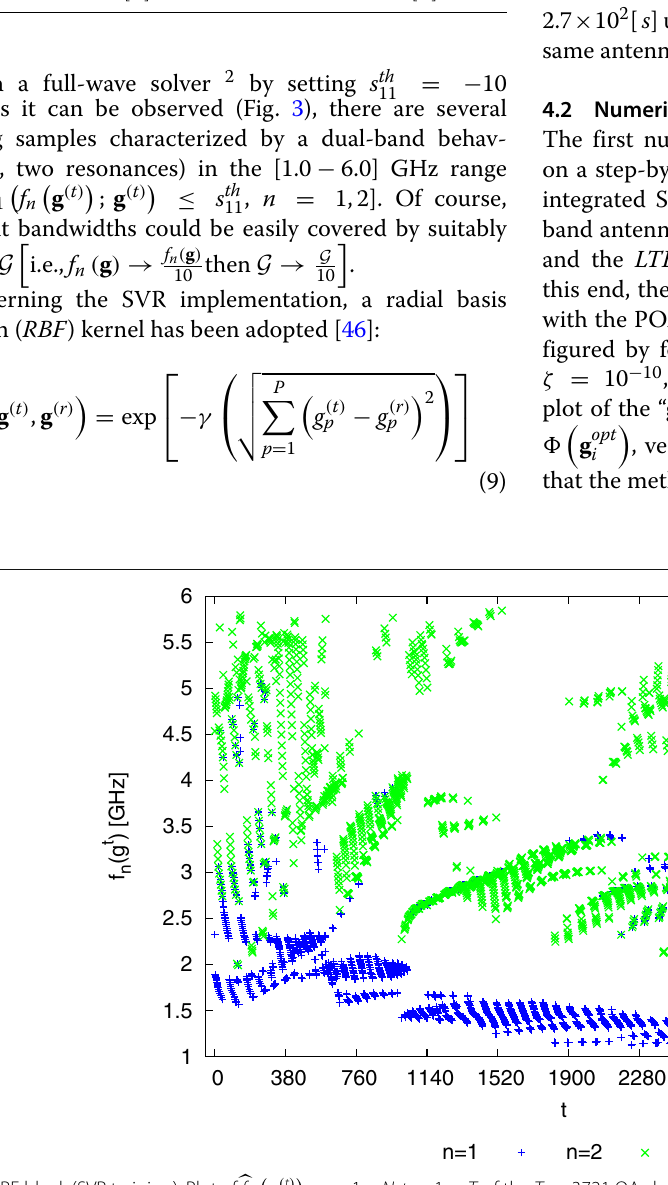
Fig. 3 PRE block (SVR training). Plot of green